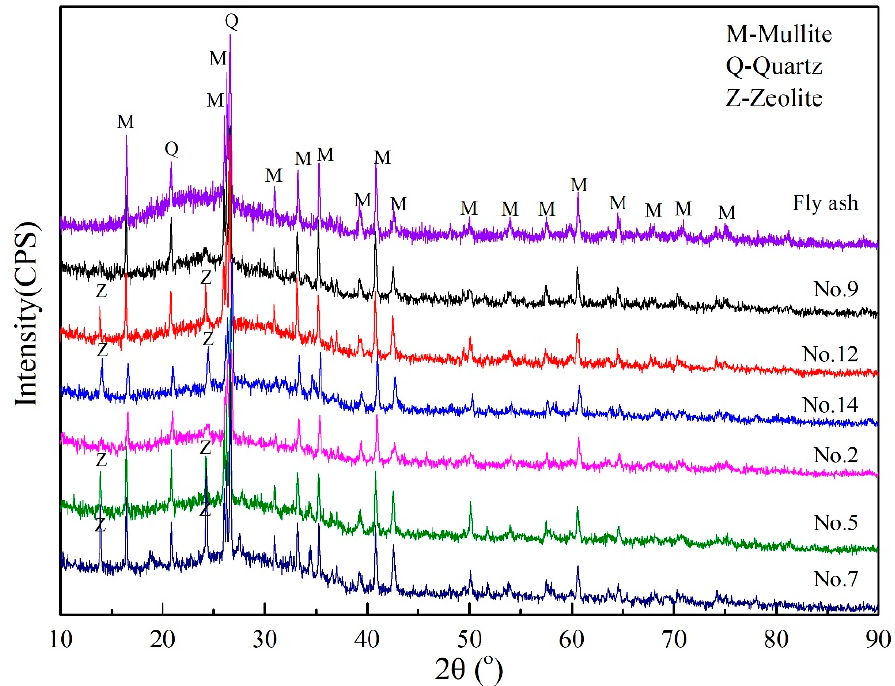
Figure 4. The X-ray diffractograms of fly ash and geopolymers synthesized with different alkali activators.